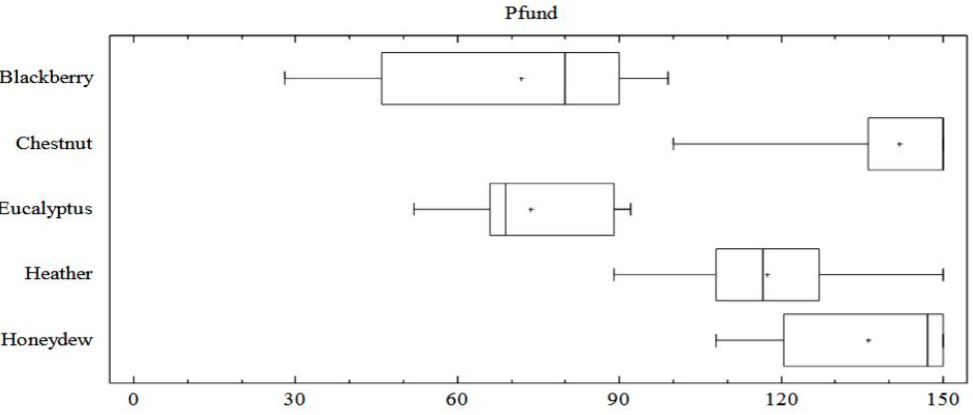
Figure 1. Box-Plot diagram of Pfund values of each honey type.